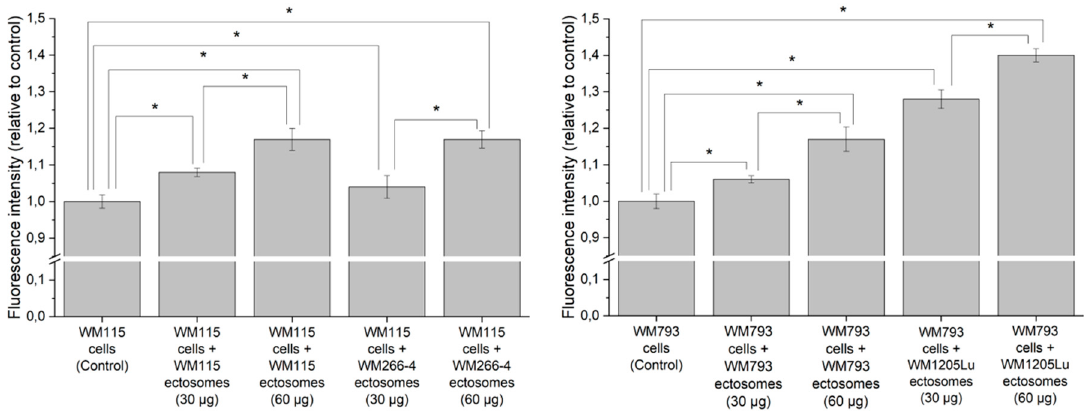
Figure 7. Effect of incubation with self-derived ectosomes and ectosomes released by their isogenic metastatic cells, on proliferation of primary WM115 and WM793 cells. Alamar Blue assay was carried out after 18 h of incubation with ectosomes. All experiments were conducted in triplicate. “*” denotes statistically significant differences (Tukey’s post-hoc test, p value < 0.05).